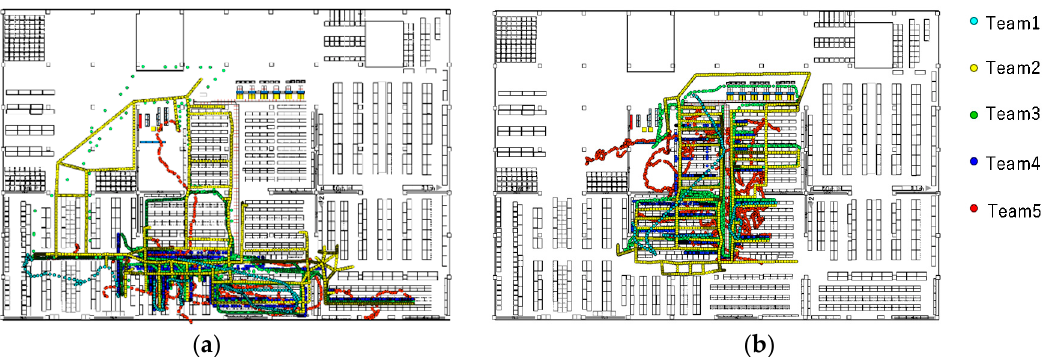
Figure 8. Example of submitted trajectories. ( a ) Trajectories for a sequence submitted by the competitors. ( b ) Trajectories for another sequence submitted by the competitions.